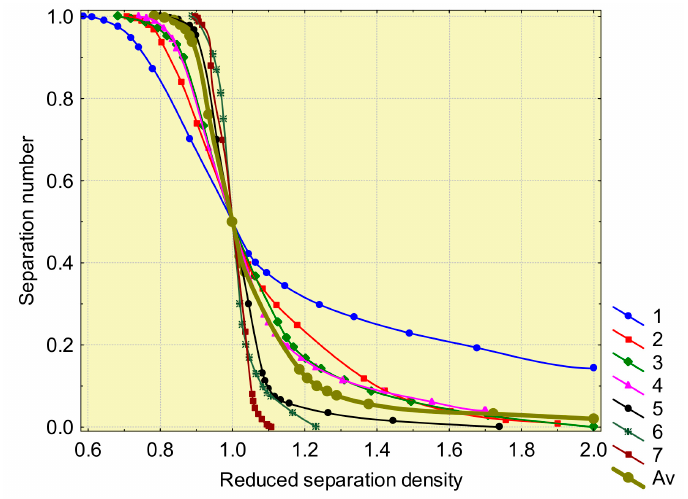
Figure 2. Partition curves of a two-product jig; 1–7: numbers of feed classes for which partition curves were